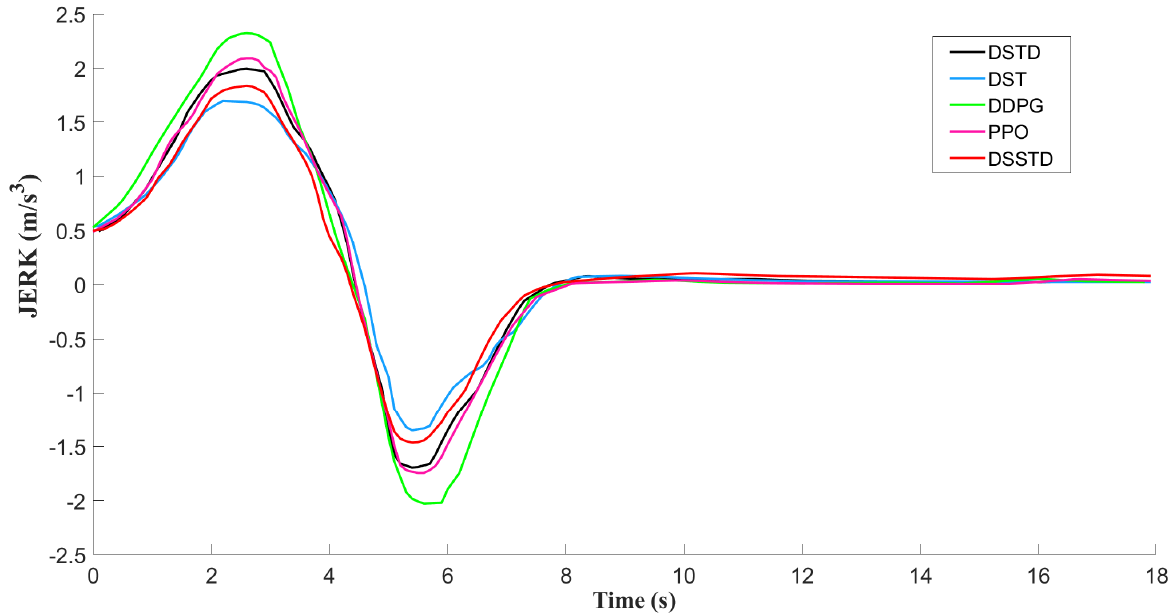
Figure 14. The Jerk curve of the AV in the test round.